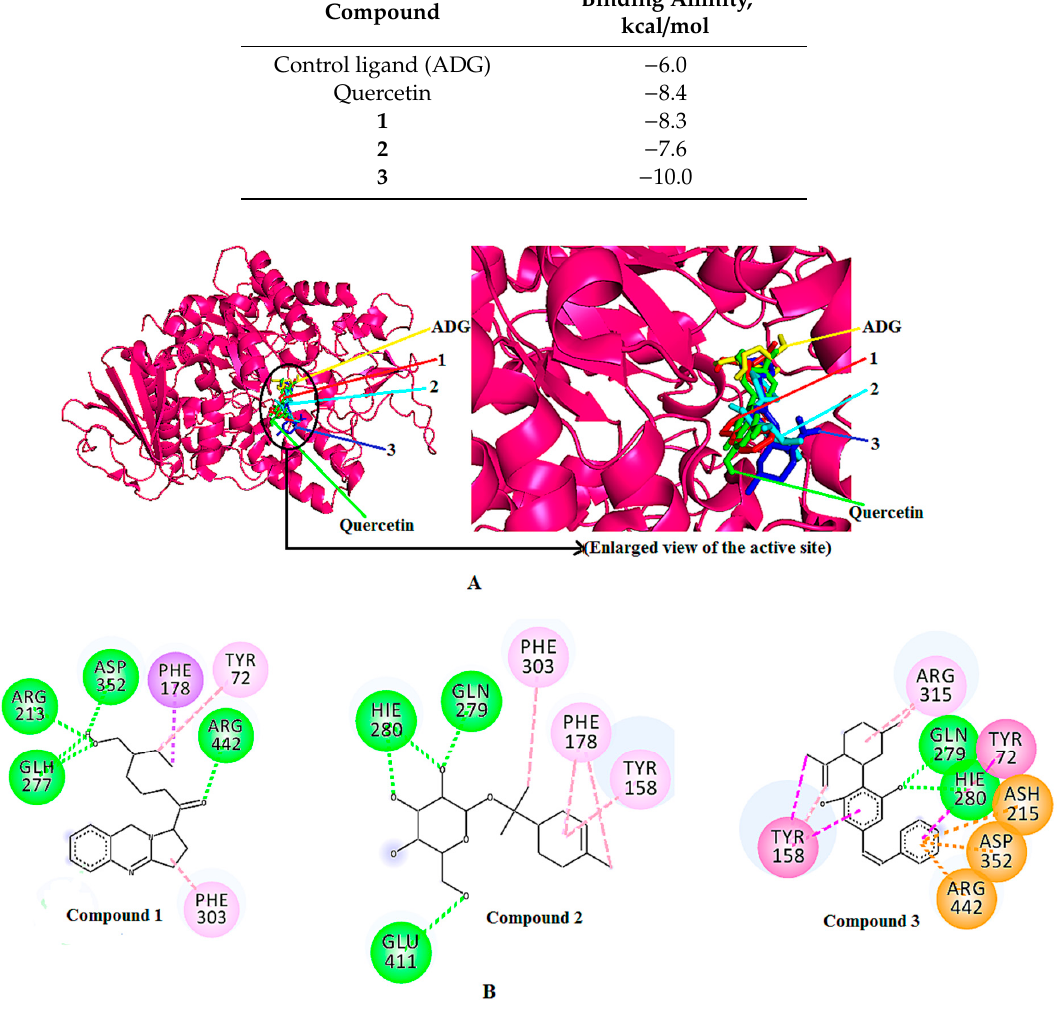
Table 2. Binding a ffi nities of the α - glucosidase enzyme (3A4A) with control ligand, the known competitive inhibitor (quercetin), and the identified active compounds.